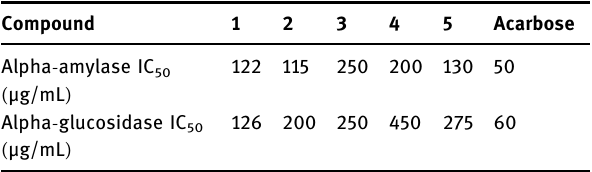
Table 3: Thiourea derivatives inhibitory potential against AChE and BuChE Compound